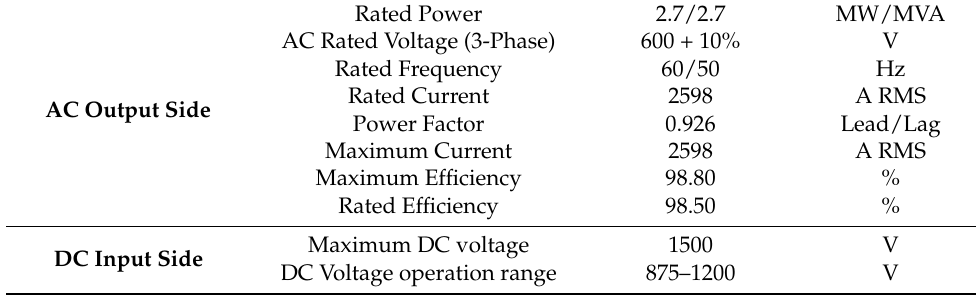
Table A1. Inverter data.